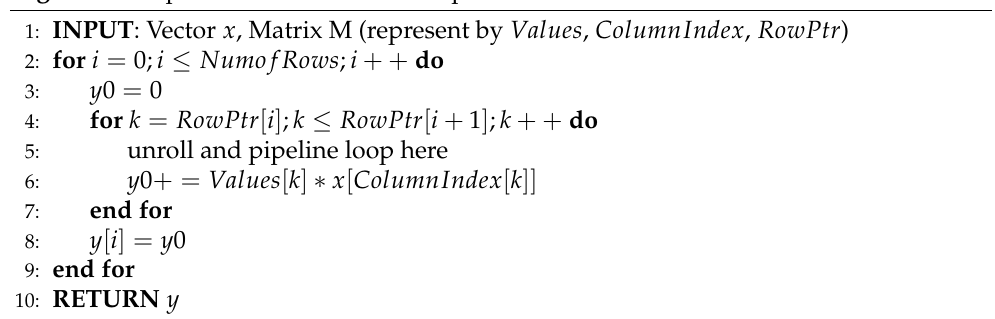
Algorithm 1 Sparse Matrix-Vector